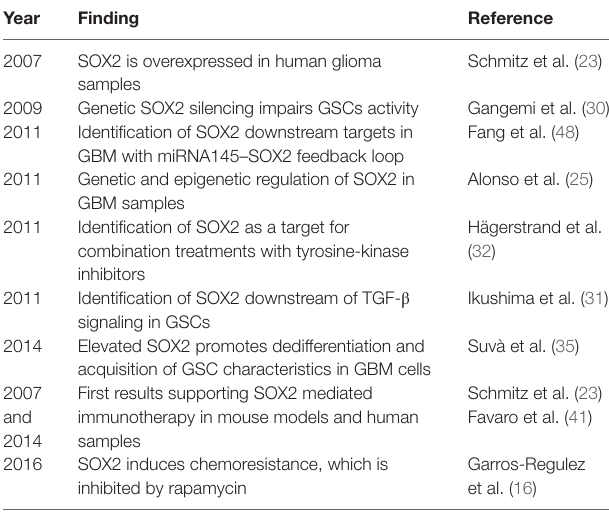
TABLe 1 | Summary of relevant findings of SOX2 in glioblastoma.